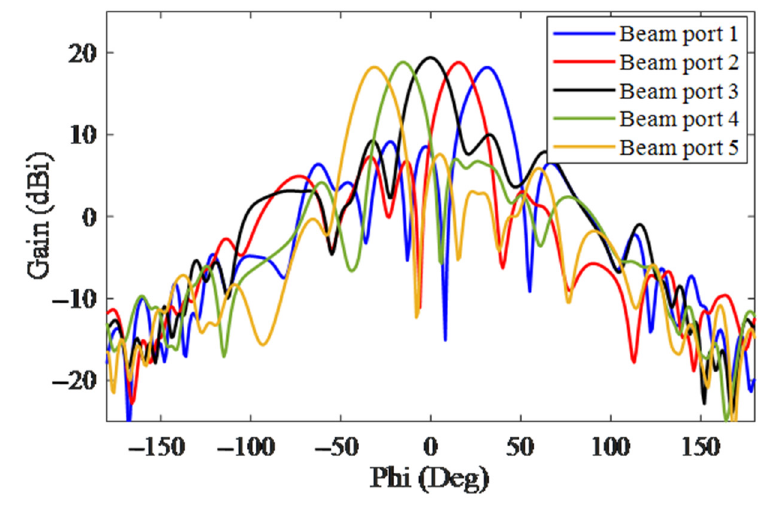
Figure 9. The simulated gain of the 2D-MBA for the excitation of different beam ports at 18 GHz.